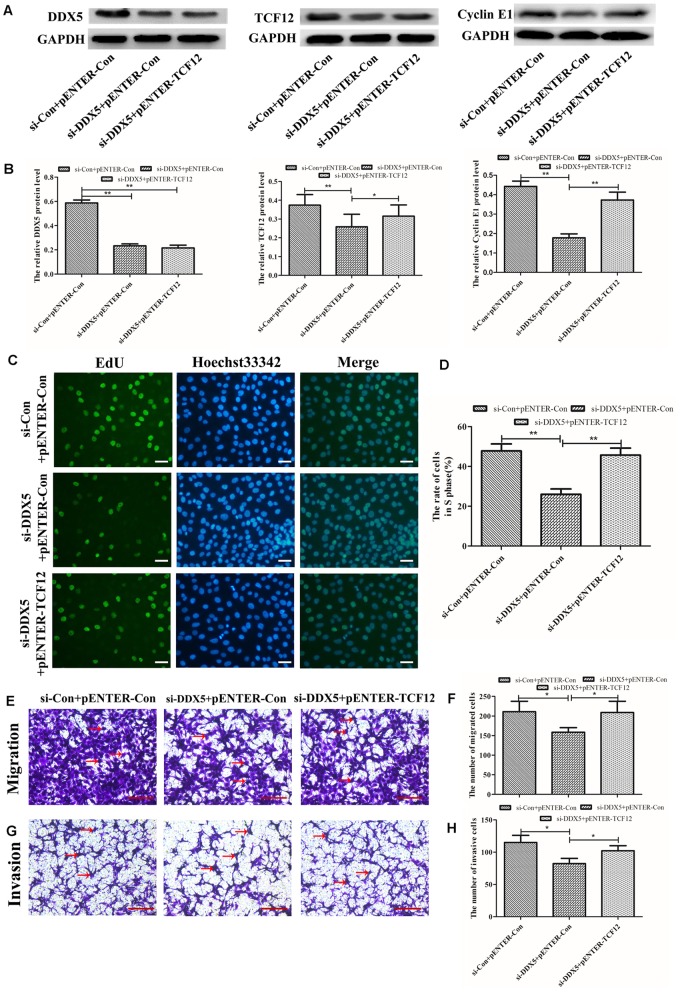
Overexpression of TCF12 reversed the cell proliferation, migration and invasion in MG63 cells induced by DDX5 knockdown accompanied by the upregulation of Cyclin E1. (A) Expression of DDX5, TCF12 and Cyclin E1 in MG63 cells detected by Western blot at 48 h after co-transfection with si-Con and pENTER-Con, si-DDX5 and pENTER-Con, or si-DDX5 and pENTER-TCF12. (B) Bar chart showed the relative DDX5, TCF12 and Cyclin E1 protein level (n = 3). (C) EdU DNA proliferation in vitro detection showed that overexpression of TCF12 reversed the decrease of the cells in the S phase induced by DDX5 knockdown, bar = 50 μm. (D) Bar chart showed the rates of cells in the S phase. (E) Migration assay showed that TCF12 overexpression reversed the decreased number of migrated cells by DDX5 knockdown and the arrows indicated to the migrated cells, bar = 200 μm. (F) Bar chart showed the data of the average number of migrated cells. (G) Invasion assay showed that TCF12 overexpression reversed the decrease of invasive cell numbers induced by DDX5 knockdown. Arrows indicated the invasive cells, bar = 200 μm. (H) Bar chart showed the average number of invasive cells. ∗P < 0.05, ∗∗P < 0.01.